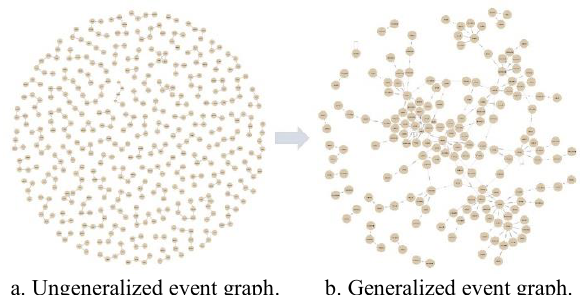
Figure 10 . Comparison before and after generalization.